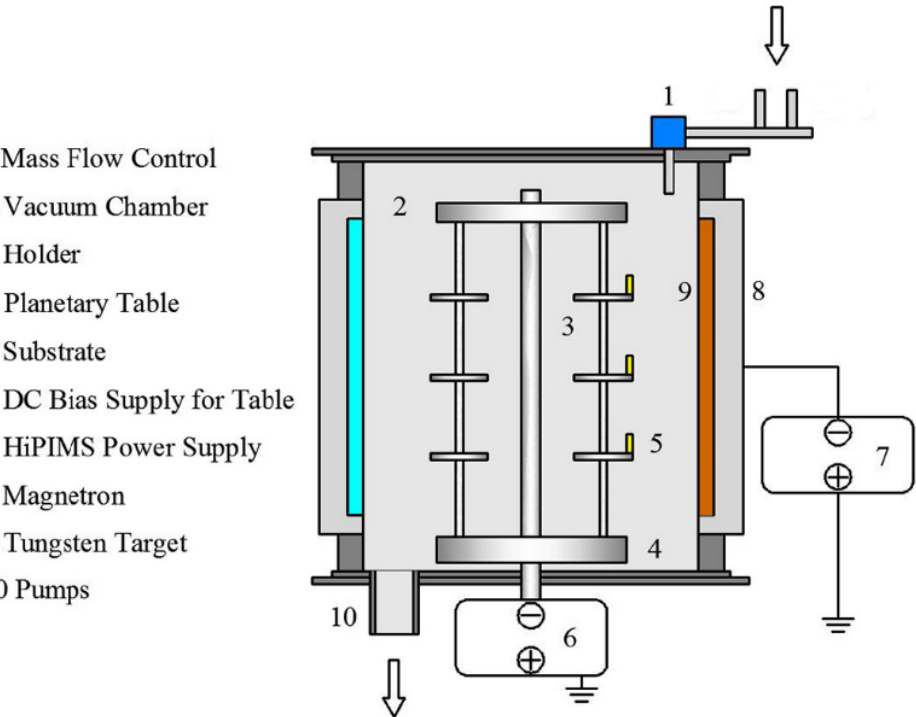
Figure 3. Schematic diagram of HiPIMS deposition setup [33]. Reprinted with permission from [33]; 2018 Elsevier.